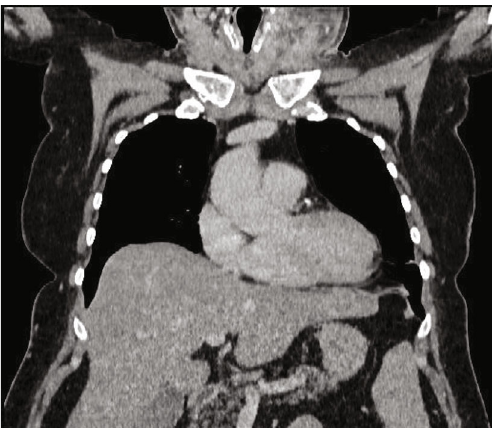
Figure 5: Initial CT of the